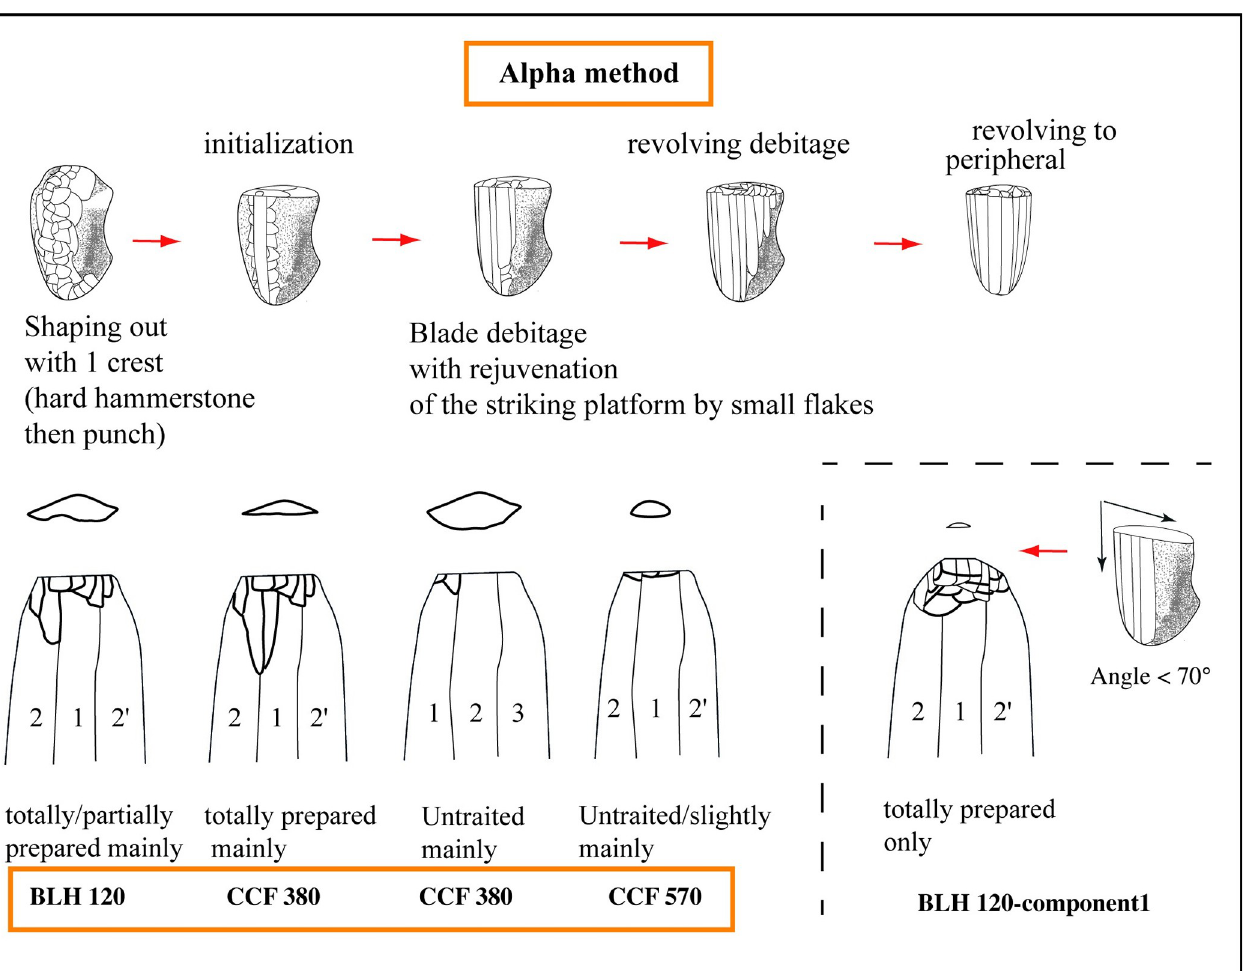
Fig 13. Schematic illustration of the Alpha knapping method and the individual variability of the knappers. This figure shows the variability of preparation methods for the the flint blades. Nevertheless, these differences belong to the modalities currently identified for the Alpha tradition. Into the house component 1 of BLH, the inclination between the striking platform and blade detachment surface suggests a very different core morphology with a seemingly plain striking platform, probably not belonging to the Alpha